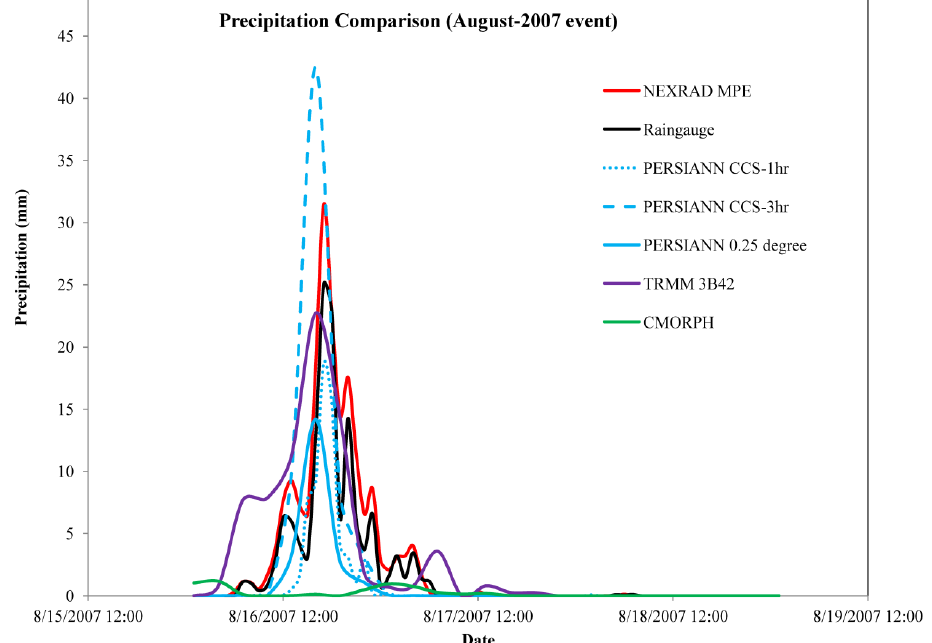
Figure 9. Basin average precipitation comparison for the August 2007 storm event.